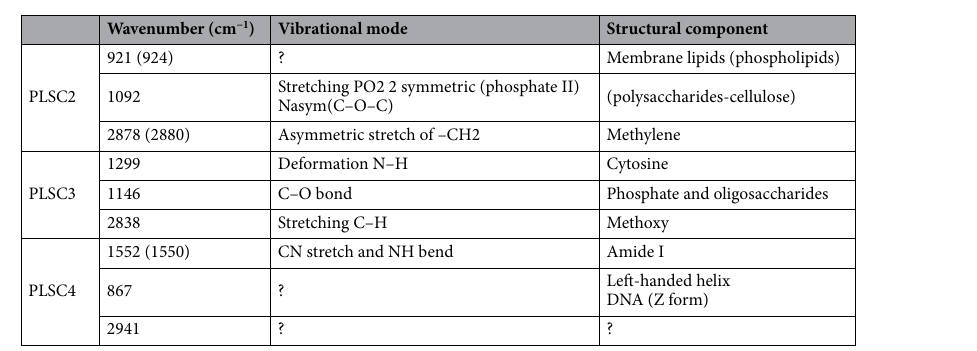
Table 1. Main vibrational modes present in the fingerprint region between 650–1800 cm −1 and the high wavenumber region between 2800–3000 cm −1 of the PLS loading spectra of PLSC2, PLSC3 and PLSC4 for the analysis of the LIQUID 1 dataset (according to Movasaghi et al. 21 and Naseer et al. 22 ).